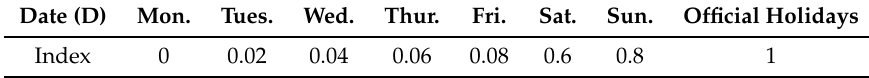
Table 1. Quantization for the factors of date.